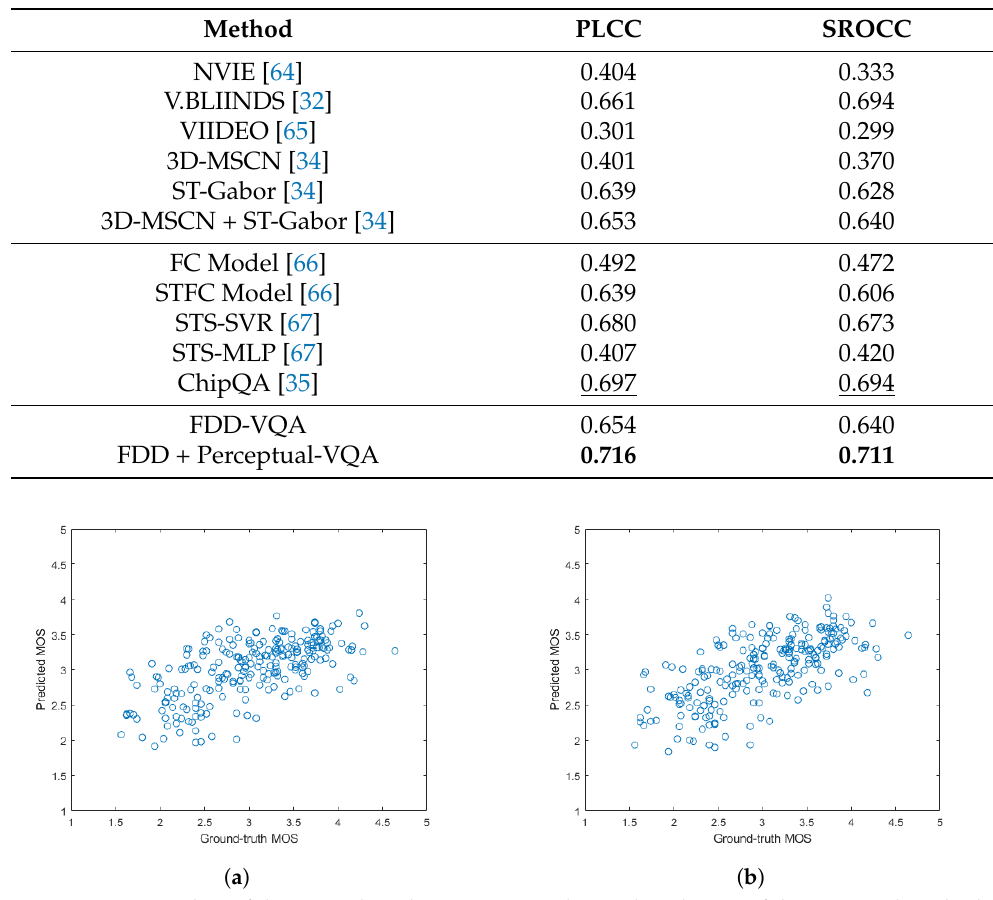
Table 12. Comparison of FDD-VQA and FDD + Perceptual-VQA to the state-of-the-art on KoNViD- 1k [22]. Median PLCC and SROCC values were measured over 1000 random train–test splits. The best results are in bold, while the second best results are underlined.